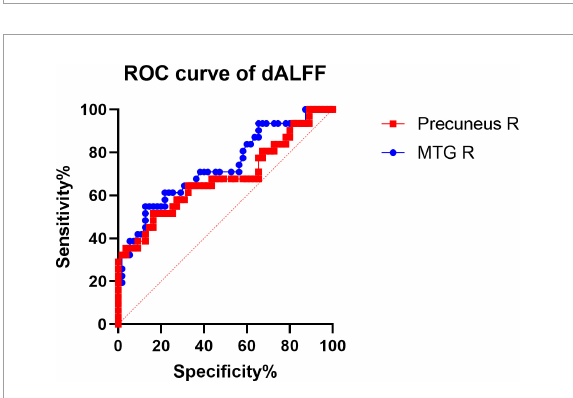
FIGURE5 Receiver operating characteristic (ROC) curve analysis of the mean dALFF values for altered brain regions. The AUCs for dALFF values were Precuneus_R: 0.68. MTG_R: right middle temporal gyrus; AUC: area under the